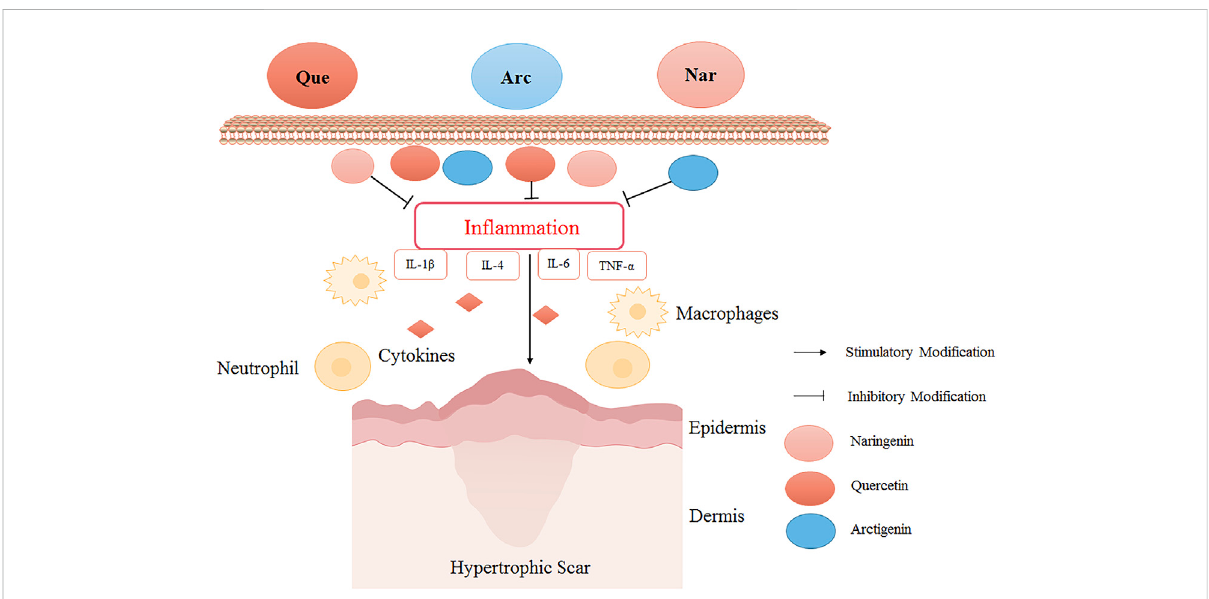
FIGURE 2 The HS inhibitory mechanism of TCM (quercetin, arctigenin, and naringenin) by reducing in fl ammation. Quercetin (Que), arctigenin (Arc), and naringenin (Nar) could inhibit the in fi ltration of in fl ammatory cells and the production of in fl ammatory cytokines to alleviate HS. Quercetin reduced the number of macrophages in the skin wound healing process, relieved in fl ammation, and reduced HS formation. Arctigenin alleviated HS by reducing in fl ammatory factors IL-1 β , IL-4, IL-6, and TNF- α . Naringin down-regulated in fl ammatory cytokines to exert its anti-in fl ammatory effect to alleviate